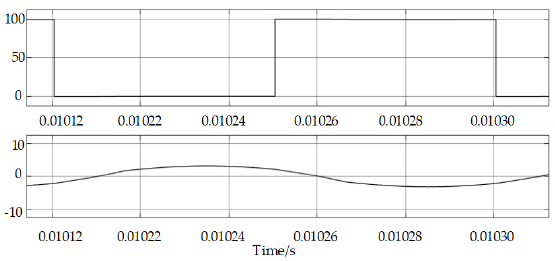
Figure 21. φ AD = 25.8° and φ AB = 152° bridge-arm A drain-source voltage and current waveforms.